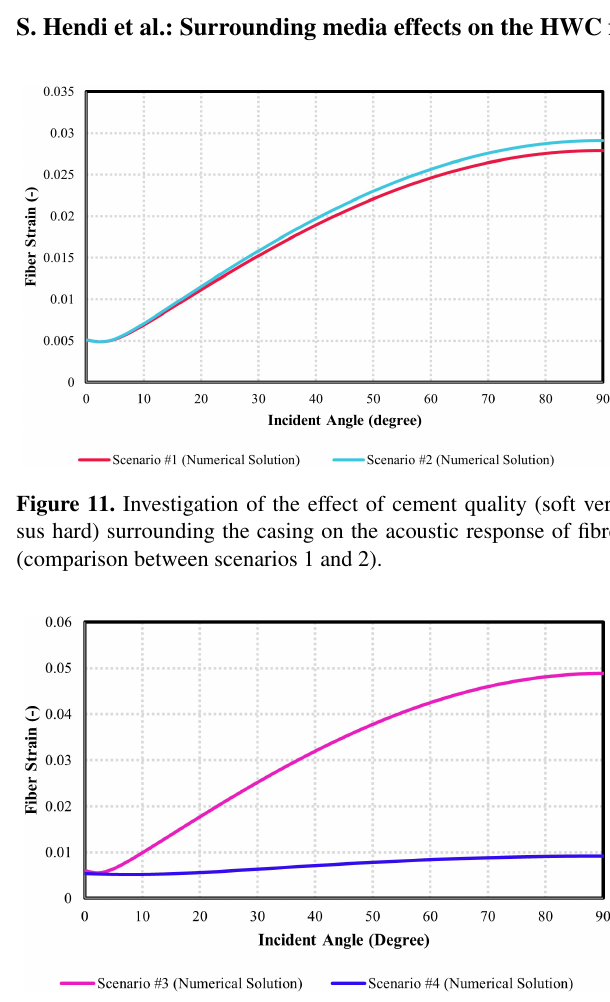
Figure 14. Investigation of the number of layers in the acoustic re- sponse of fibre (comparison between scenarios 1 and